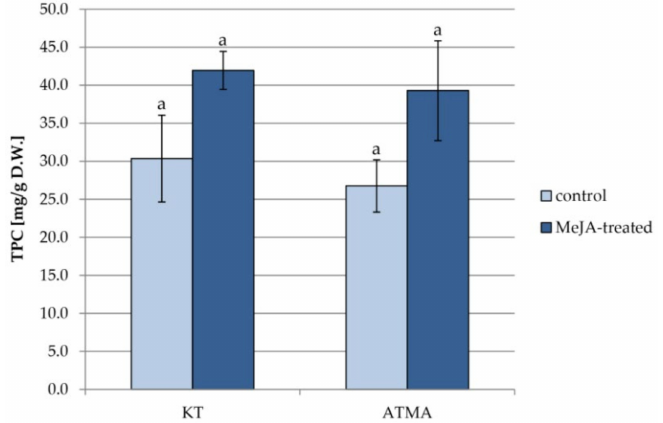
Figure 6. The total phenolic content (TPC) in methanol extracts obtained from control and elicited hairy roots of KT and ATMA lines. Results not sharing a common letter are significantly different ( p <